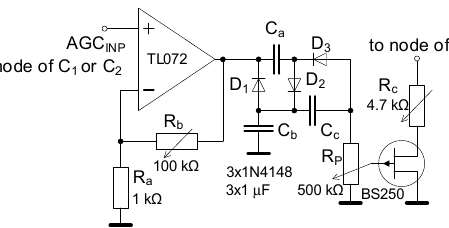
Figure 14. System for amplitude stabilization of the designed oscillator used in the experiments.